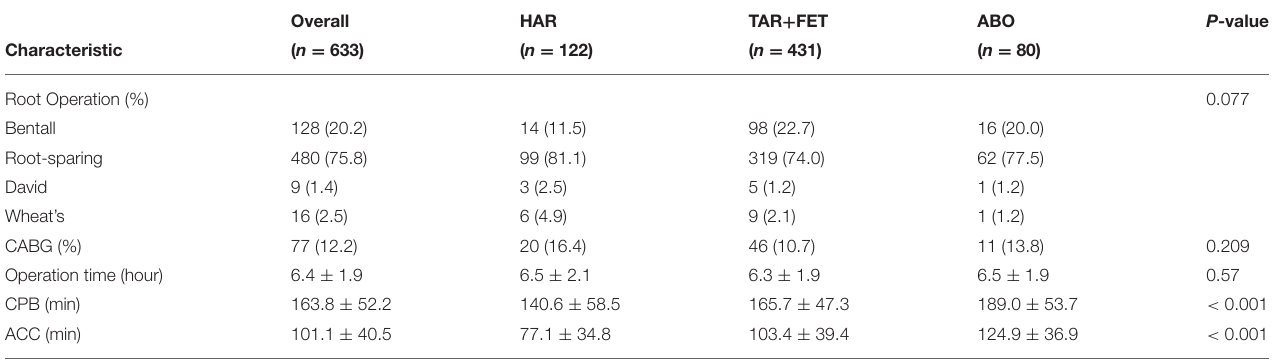
TABLE 3 | Operative variables for the total cohort and each group before using the matching weight method. Overall HAR TAR + FET ABO P -value